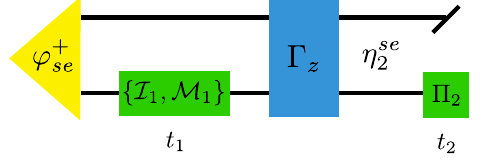
FIG. 10. First two times of a genuinely quantum process. The system and environment begin in a Bell state φ þ . Between times se t 1 and t 2 , the map Γ is implemented, which biases the system in z the z basis if any CPTP map M 1 ≠ I 1 is performed [see Eq. (70)]. The label η se 2 refers to the joint system-environment state immediately prior to t 2 [see Eqs. (71) and (72)]. Classicality implies that the POVM Π 2 must be chosen such that it is unable to detect biases in the z basis. Although this is always possible when only two times are considered, in general, classicality requires satisfaction of a growing number of constraints on the choices of later measurements, which can eventually lead to contradiction, implying the existence of genuinely quantum processes (see Appendix